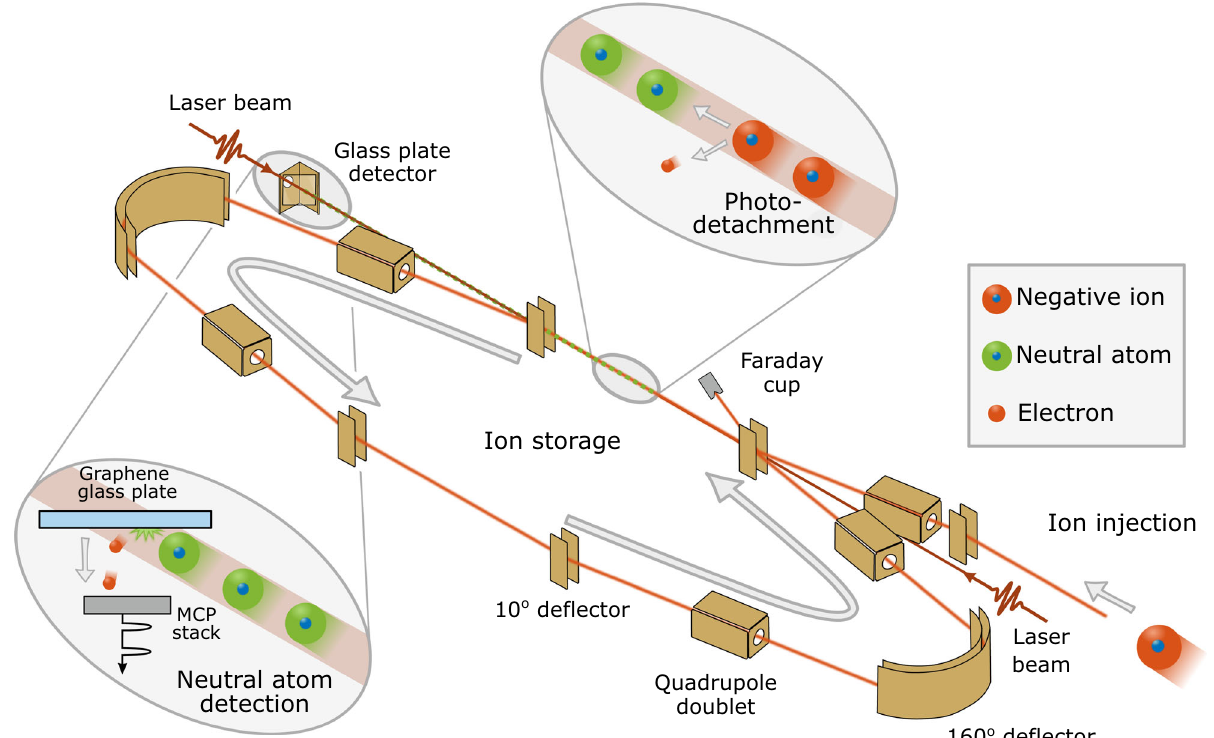
Fig. 2 | A schematic ofthe experimental setup. Ions are injectedinto the storage ring and photodetached using a continuous laser in a parallel alignment along the straight section of the injection line. The laser can be applied in either co- propagating or counter-propagating directions. The neutral atoms created in the photodetachment process are detected by a detector system located after the